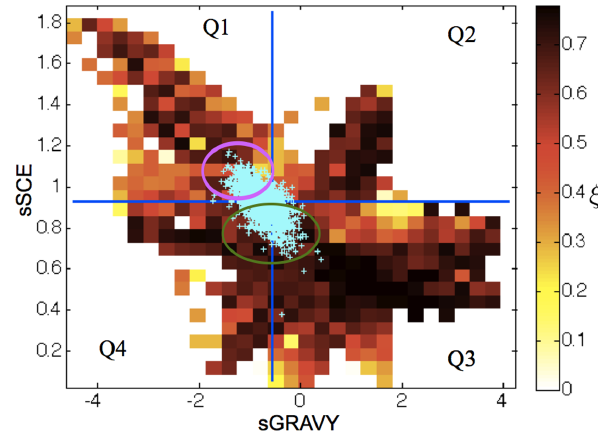
Figure 6. Projection of the average predicted propensity j over the sGRAVY-sSCE plane. Blue lines divide the plane in four quadrants (Q1, Q2, Q3, and Q4) based on the average sGRAVY and sSCE of the proteins in the NESG database. Cyan pluses represent the projection of the 1,612 structures downloaded from the PDB, whose distribution is used to generate Tables 1 and 2. The green circle broadly indicates the region where the sSCE is the main driving force to crystallization, while the fuchsia circle indicates the region where specific chemical complementarity plays a more significant role. The model also captures the reduction in propensity associated with limited protein solubility at very low sSCE.